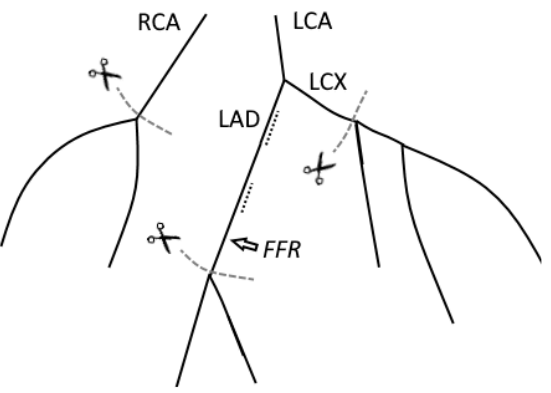
Figure 1. Cutting branches of full trees to generate reduced trees for Patient 1. Dotted lines designate stenoses. We preserve arteries and junctions proximal to FFR-measurement sites while removing the